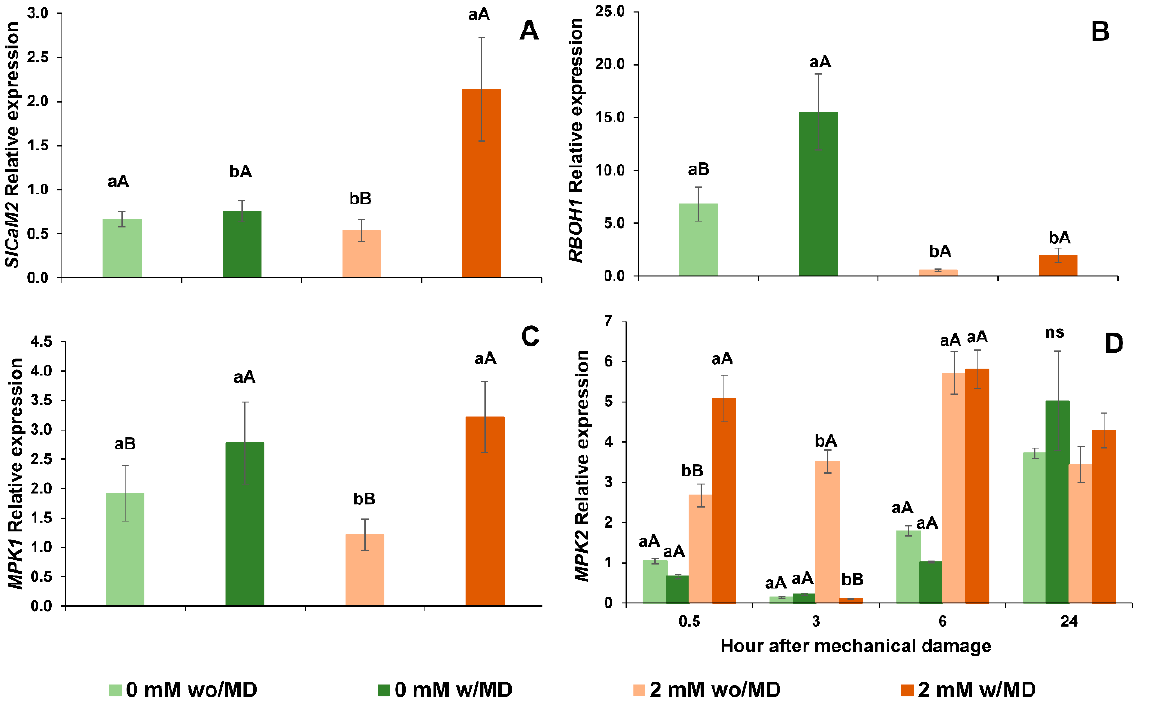
Figure 1. Gene expression, ( A ). SlCaM2 damage x calcium p < 0.005, ( B ). RBOH1 calcium × damage p < 0.016, ( C ). MPK1 damage × calcium p < 0.023 and ( D ). MPK2 time × damage × calcium p < 0.027 in Solanum lycopersicum “cv. Micro-Tom” grown with variation in calcium concentration (mM) and with (w/MD) or without (wo/MD) mechanical damage. Different lowercase letters indicate a significant difference in calcium levels within wo/MD or w/MD plants. Capital letters test wo/MD and w/MD plants within the same calcium level. ns = not significant at 5% Tukey test. Bars correspond to averages, whiskers to ± SE ( n = 3).